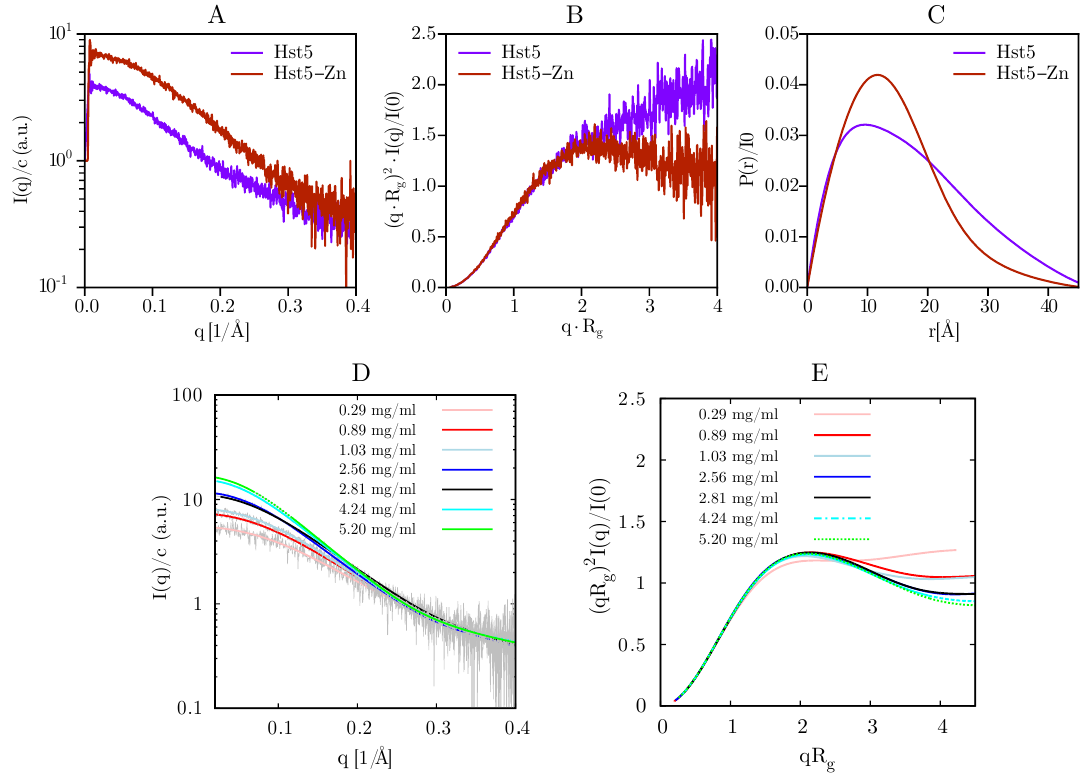
Figure 3. SAXS analysis of Hst5 in the absence and presence of ZnCl . ( A ) Comparison of the 2 intensity function normalised by concentration for 0.9 mg/mL Hst5, in 20 mM MES-buffer, pH 6.7, 150 mM NaCl and 4 mM ZnCl . ( B ) SAXS data shown as a dimensionless Kratky plot. ( C ) Plot of the 2 intra-peptide distance distribution determined by indirect Fourier transform, for Hst5, with either NaCl (purple curves) or with ZnCl (red curves). ( D , E ) Concentration dependent SAXS-measurements 2 of Hst5 in the presence of ZnCl , showing the intensity curve normalised with protein concentration 2 and the corresponding Kratky